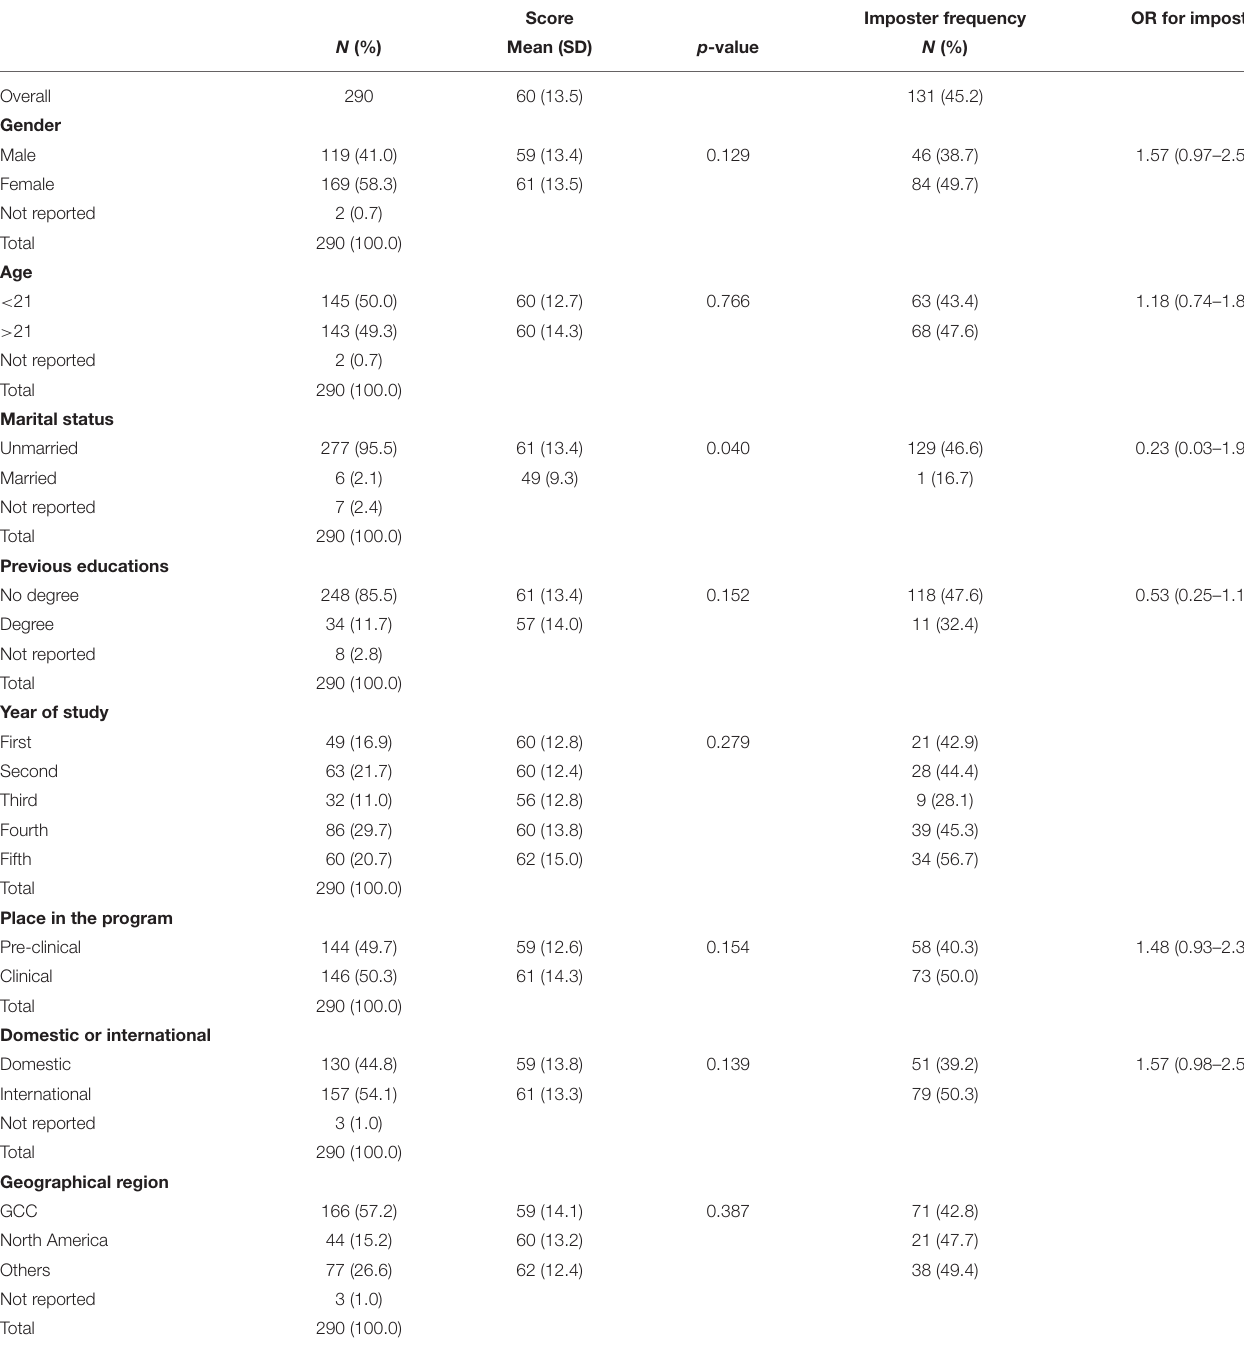
TABLE 2 | Mean student’s scores on the clance impostor phenomenon scale and frequency of imposterism. Score Imposter frequency OR for